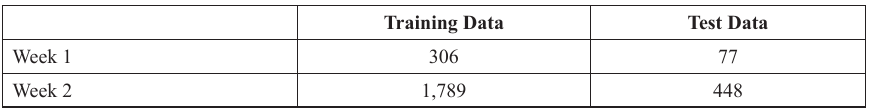
Table 5. Training and test data